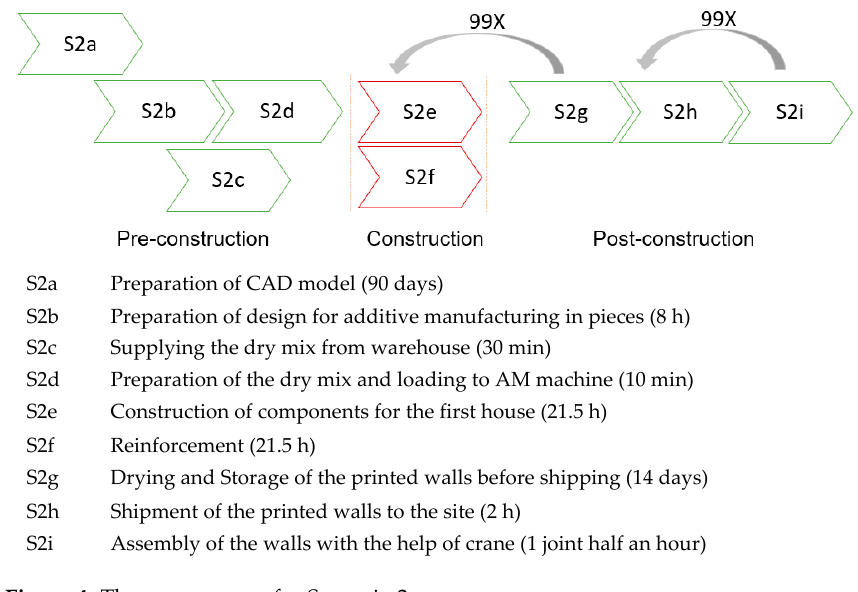
Figure 4. The process map for Scenario 2.